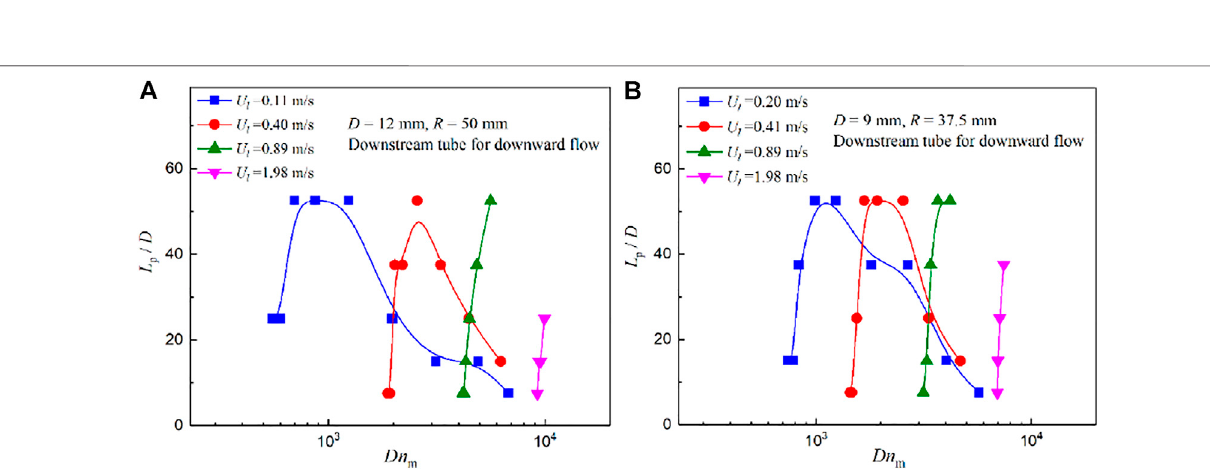
FIGURE 10 | Effect of the mixed Dean number Dn m on the dimensionless perturbation length L p / D . (A) Downstream tube for downward fl ow D = 12 mm, R = 50 mm and (B) Downstream tube for downward fl ow D = 9 mm, R = 37.5 mm.